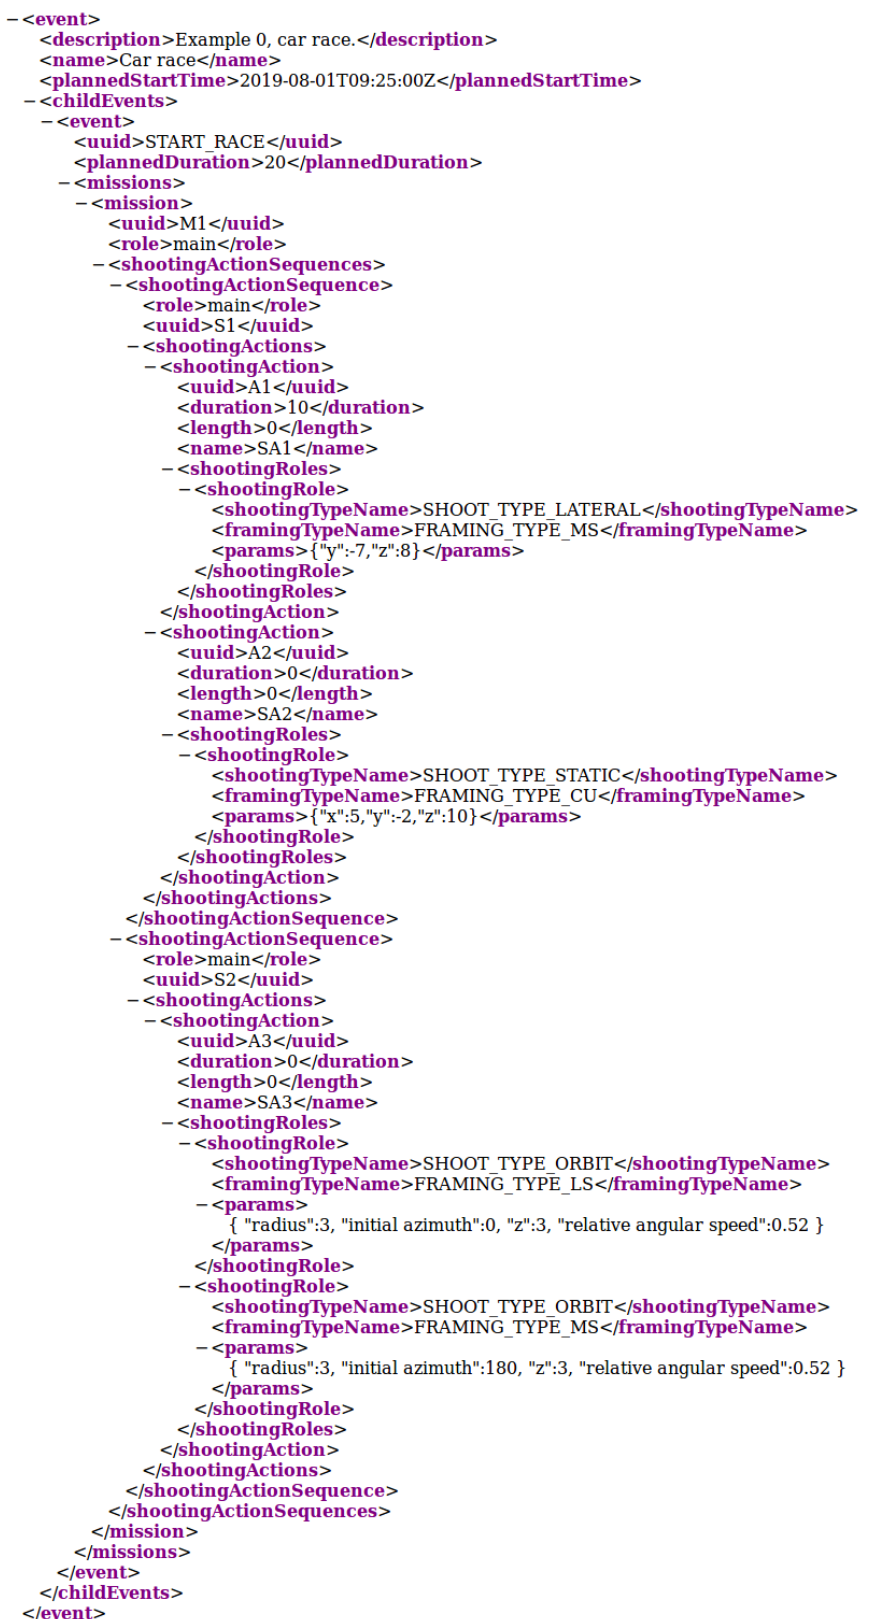
Figure 9. Example XML describing our race shooting